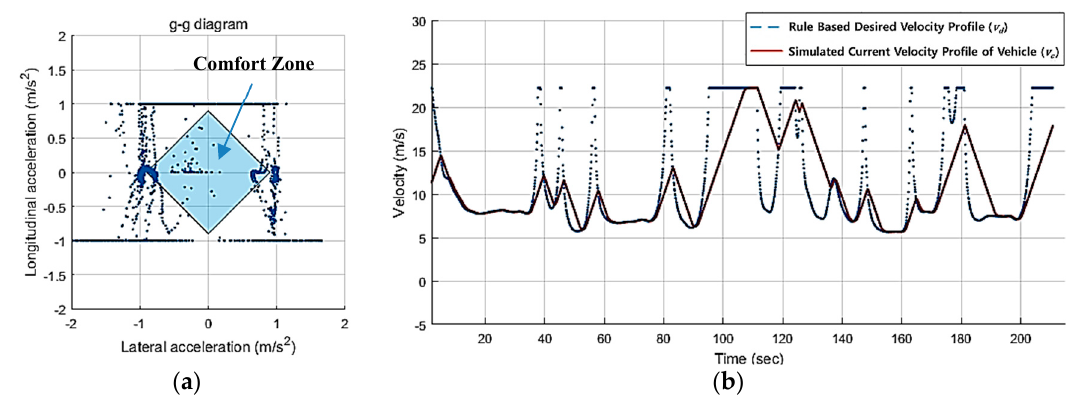
Figure 8. Simulation results of the path following control with the conventional velocity planning set by 𝑎 (cid:3052) = |0.9 m/s (cid:2870) | , ( a ) GG diagram and ( b ) velocity profiles during SIL test.